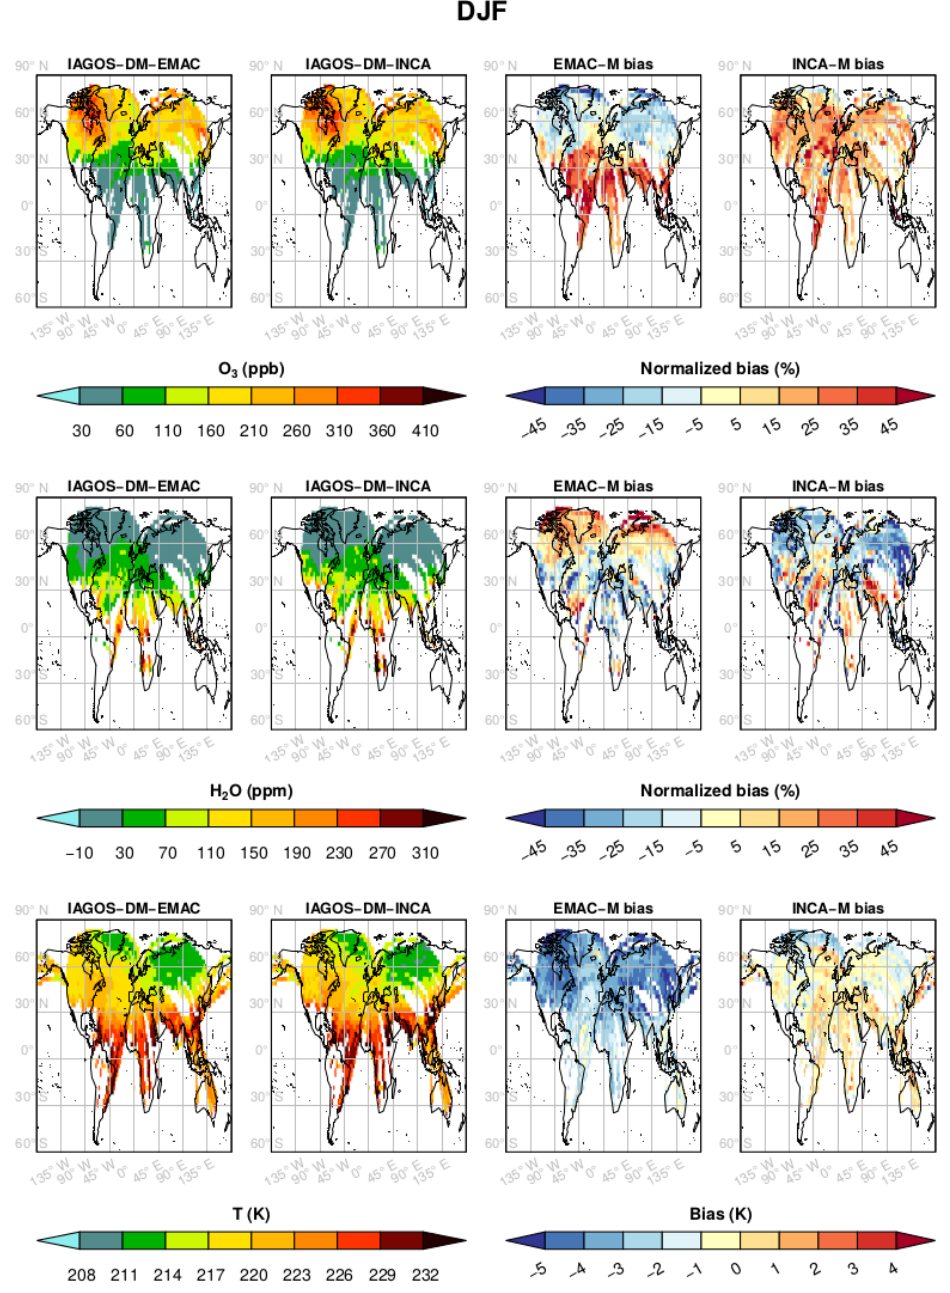
Figure A9. Same as Fig. A8 for boreal